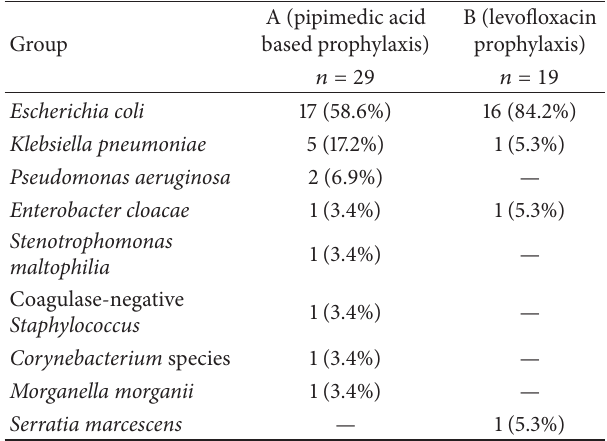
Table 3: An overview of bacterial isolates from blood and urine